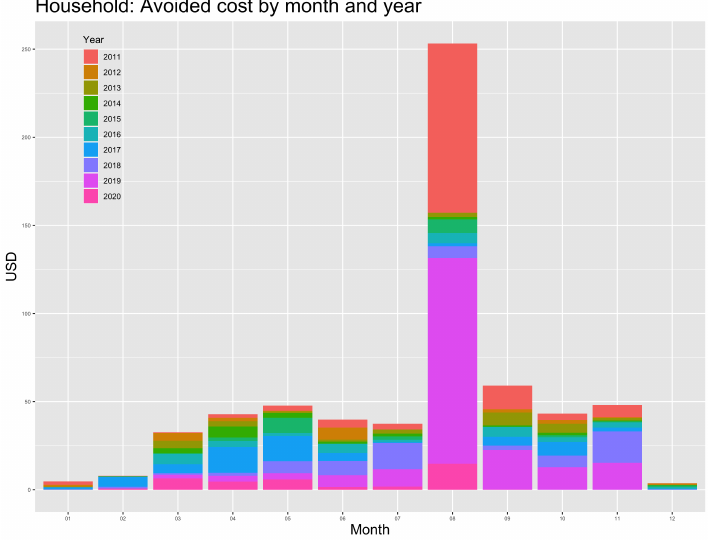
Figure 1. Avoided cost by month and year at USD 150 strike